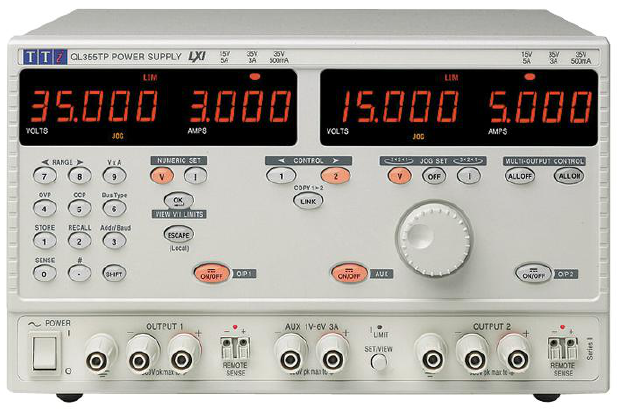
Figure 26. TTi QL355TP power